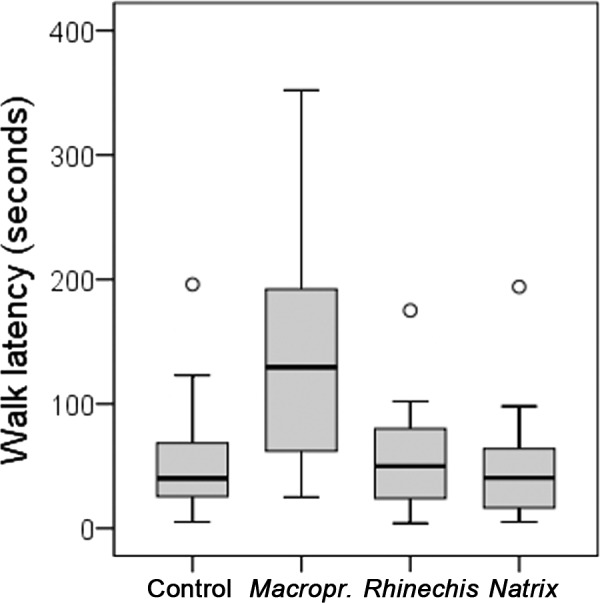
Boxplots of the time to the first normal movement, or ‘walk latency’, in seconds, of Podarcis siculus lizards of Es Canutells (Menorca, Spain) for the four treatments (Macroprotodon mauritanicus, Rhinechis scalaris, Natrix maura, and the odourless control).